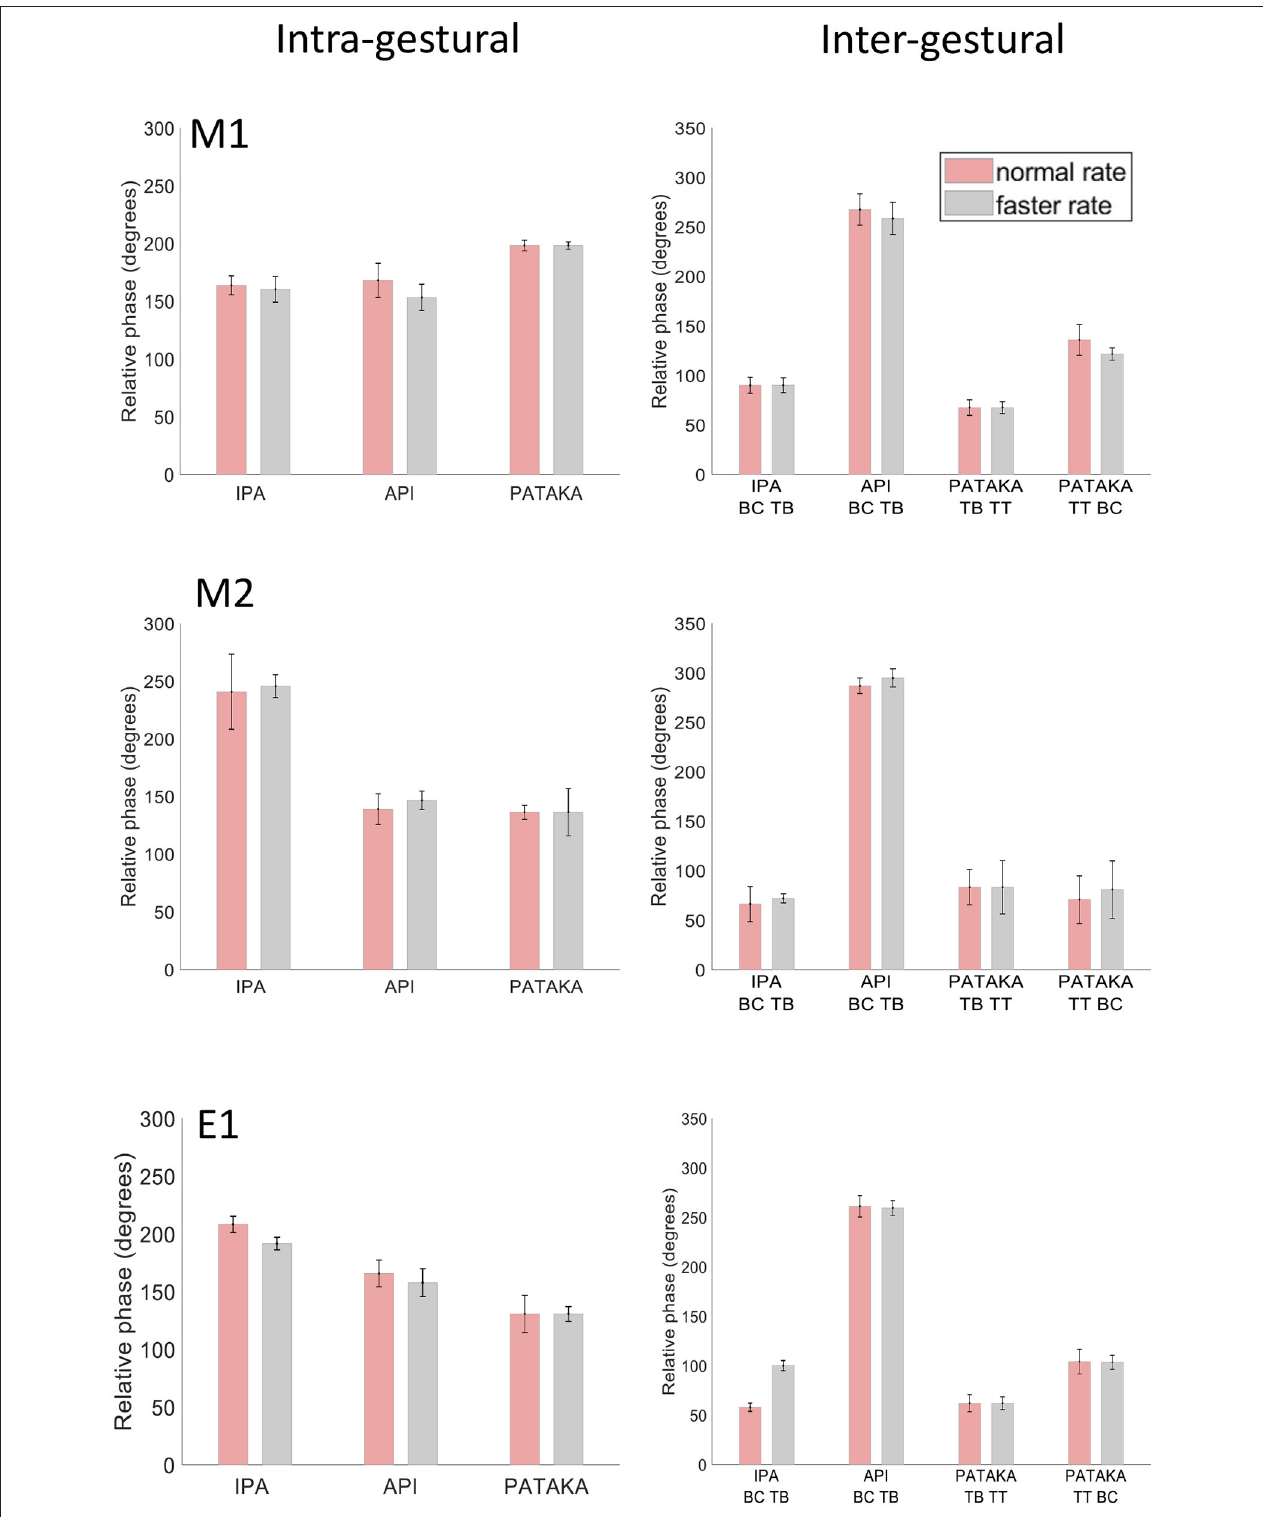
FIGURE 5 | Mean and SD of relative phase for inter- and intra- gestural coordination for participants M1, M2 and E1 at normal and faster rates for productions of [ipa], [api] and [pataka].